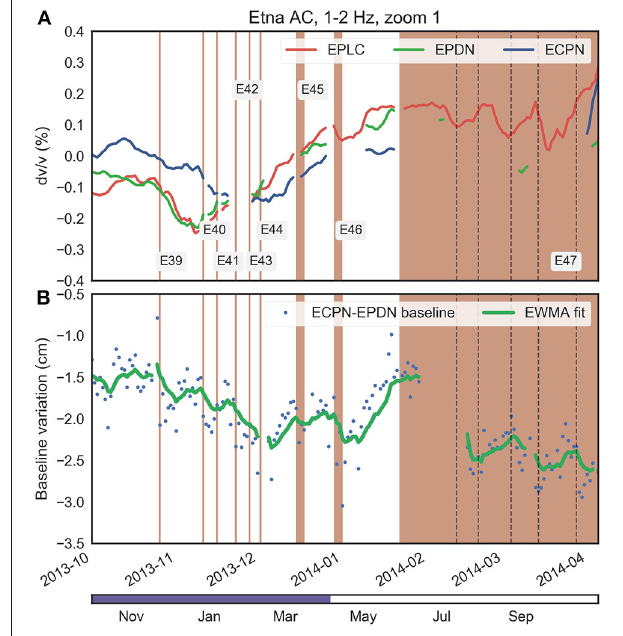
FIGURE 3 | Seismic velocity variation at stations ECPN, EPLC and EPDN (A) and variation in baseline length between GPS stations ECPN and EPDN (B) between October 2013 and April 2014. The green line is the exponentially-weighted moving average with a center of mass of 5 (EWMA) of the baseline variation. The orange zones are labeled eruptive episodes described in Table 1 and the vertical dashed black lines are simultaneous variations of dv / v at station EPLC and baseline length ECPN—EPDN during E47. The sequence of episodes from E39 to E46 are explosive, the following episodes E45 to E47 change to less explosive Strombolian and mainly effusive activity on the eastern flank of the